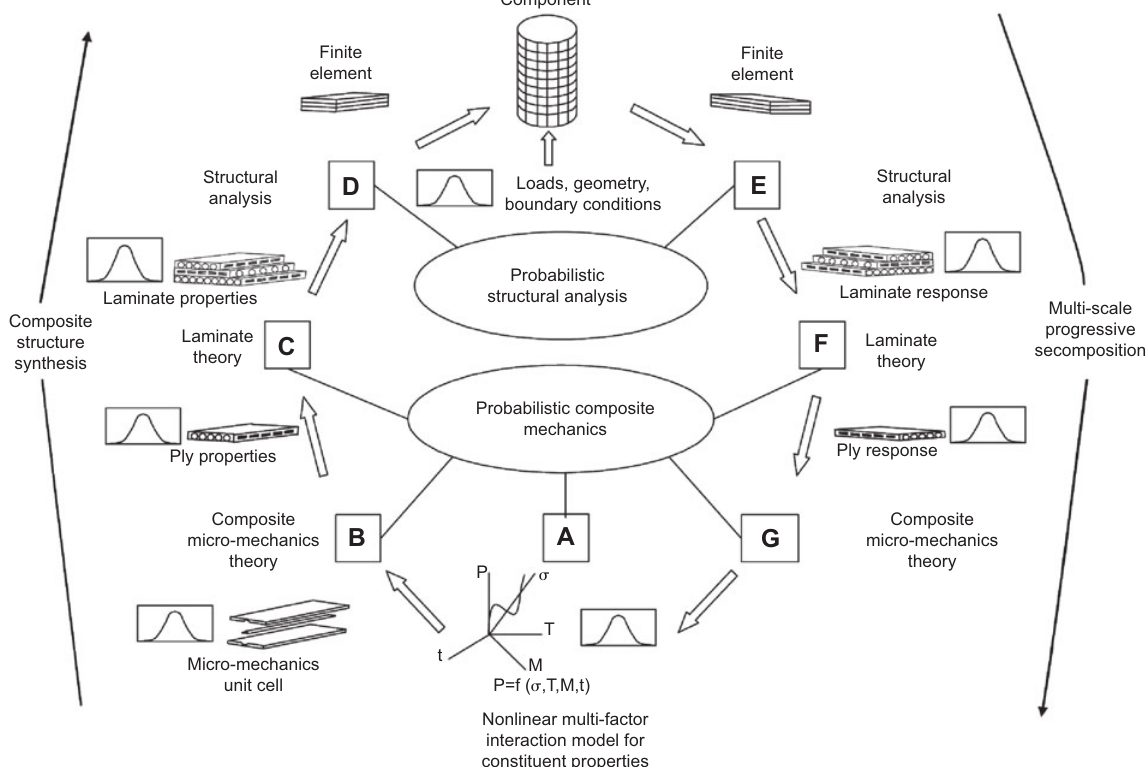
Figure 6 Modular chart for the IPACS computer.